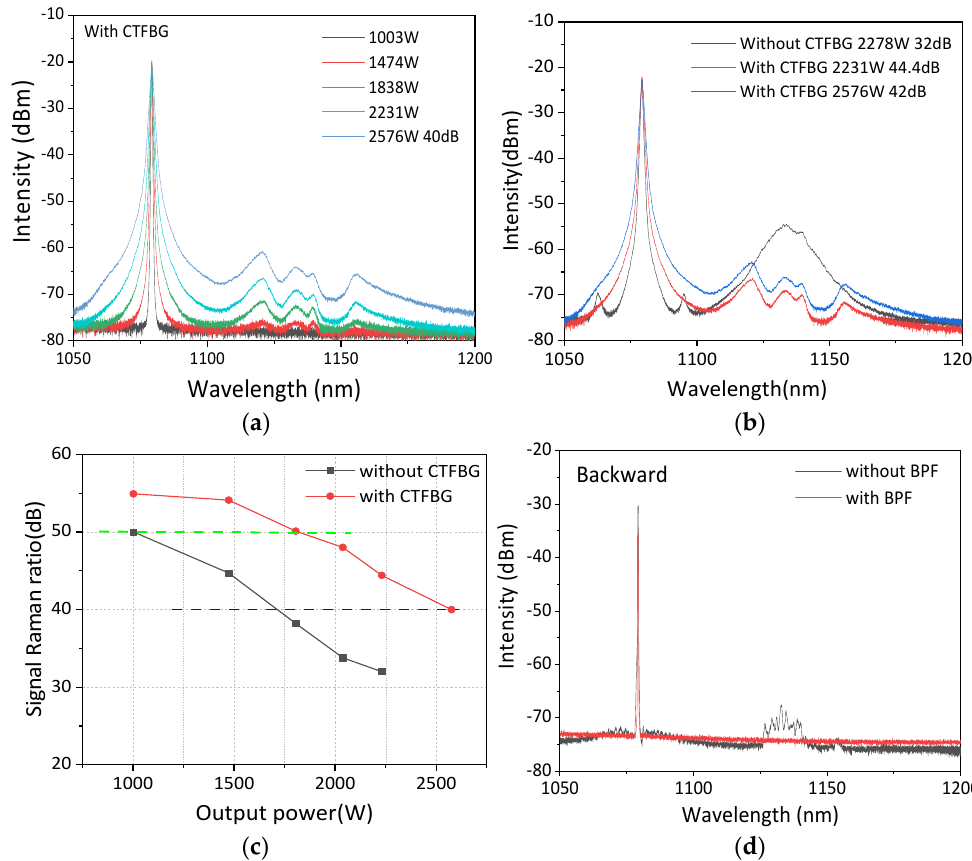
Figure 5. ( a ) The output spectrum versus output power. ( b ) The forward spectrum comparison with and without CTFBG at their highest power. ( c ) The signal to Raman ratio versus output power. ( d ) The backward spectrum comparison with and without BPF.